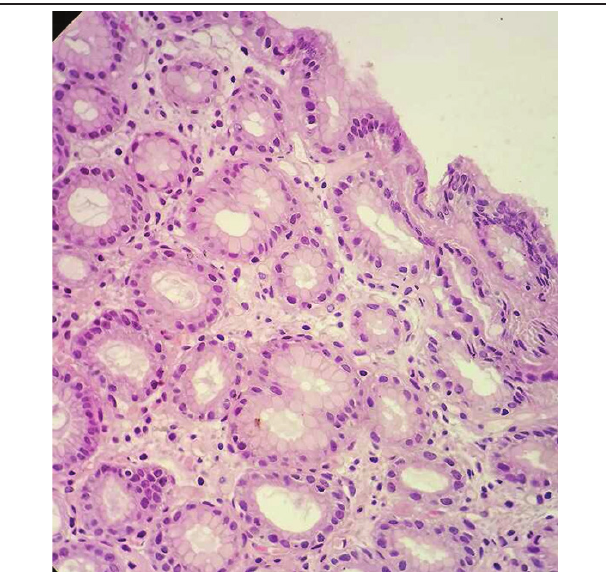
figurE 3 − Normal gastric body